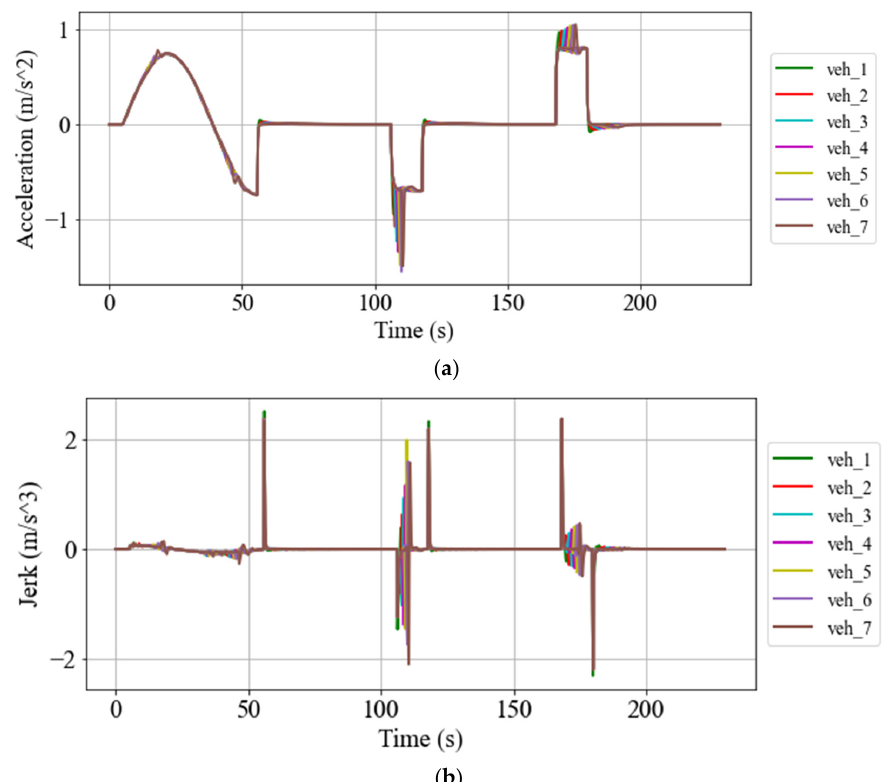
Figure 6. Variations in acceleration ( a ) and jerk ( b ) of participant vehicles in the platoon system with respect to speed trajectory followed by the leading vehicle. respect to speed trajectory followed by the leading